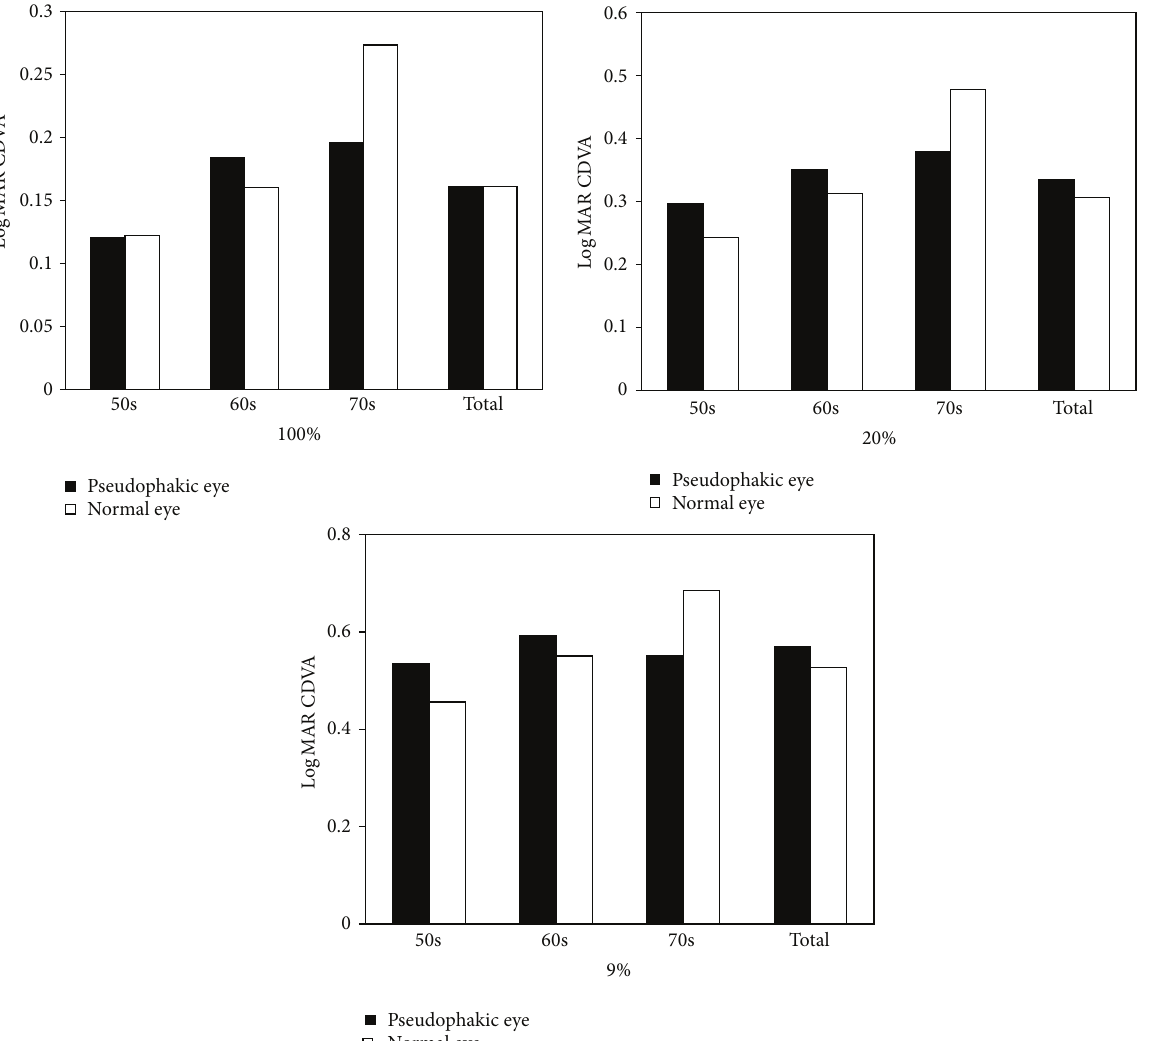
Figure1:Simulatedvisualacuity(meanVAlogMAR ± SD)ofnormalversuspseudophakiceyesatvarioussimulatedcontrastlevels,compared by age group.